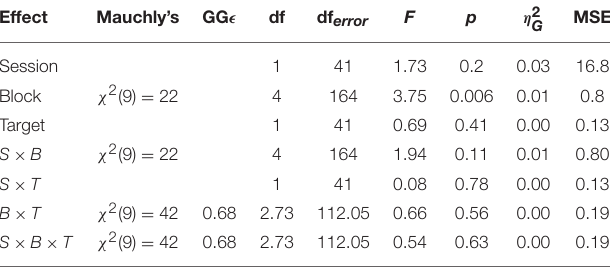
TABLE 2 | Analysis of variance for sugar factory task with confidence as dependent measure.